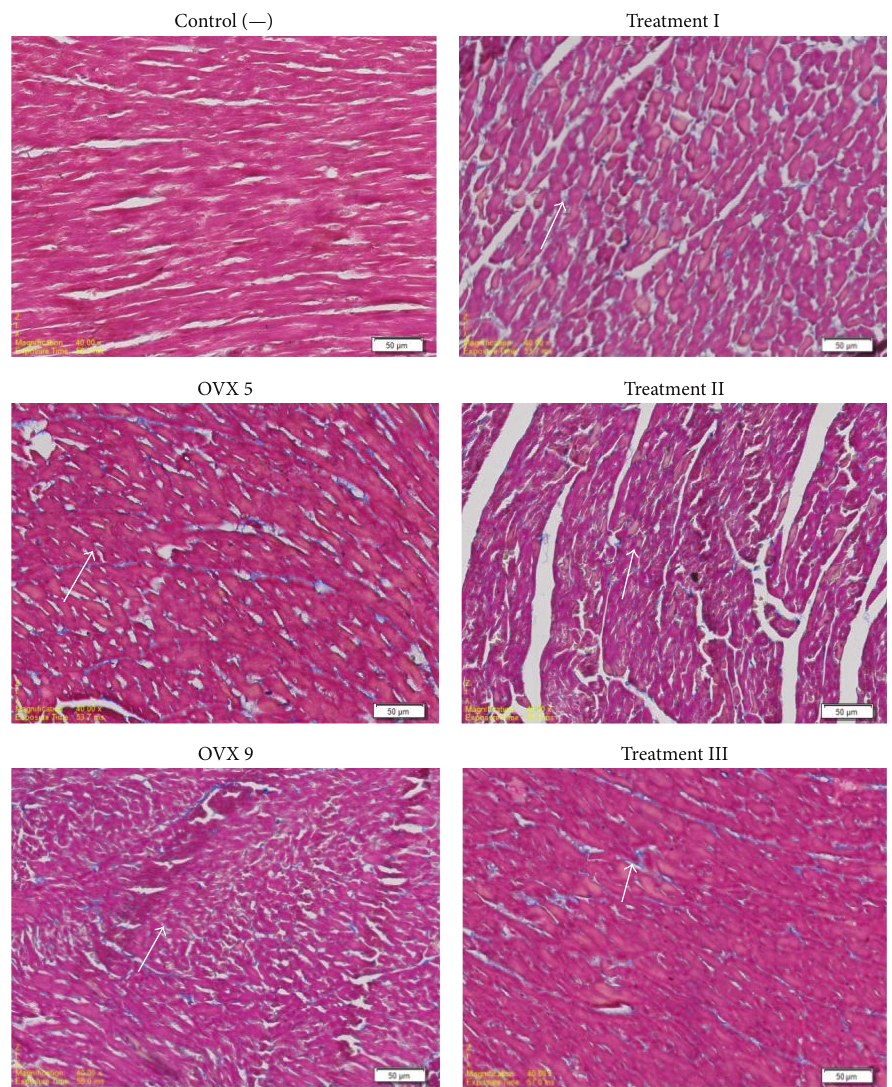
Figure2:Masson’sTrichromestainingofventricularhistologicpreparation(ocularmagnification4x).Bluecolorindicatesventricularfibrosis (marked with white